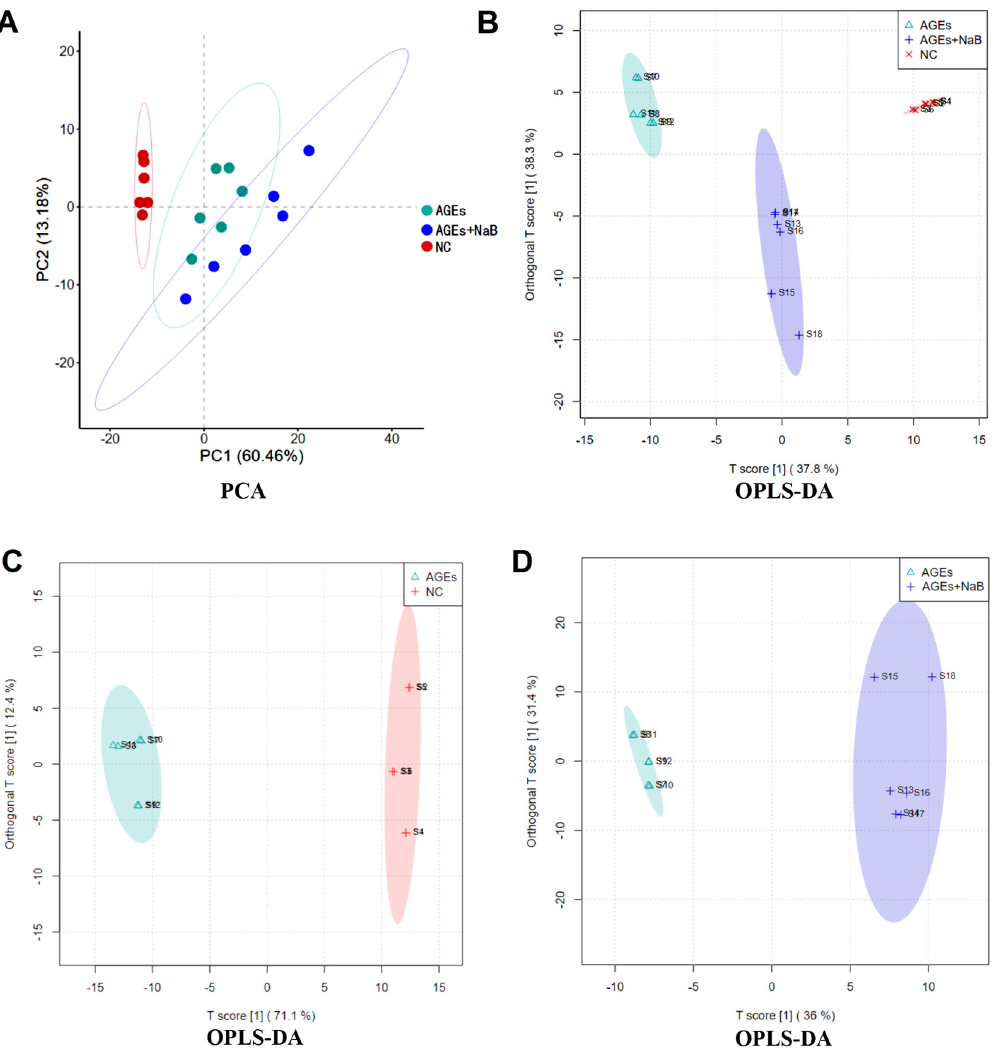
Figure 4. The PCA ( A ) and OPLS-DA ( B – D ) score plot. The NC group (red), the AGEs group (green) and the AGEs+NaB group (blue) ( n = 6/group). Table 1. Trend of differential metabolites of THP-1 cells using t -test ( p < 0.05) and OPLS-DA analysis (VIP >